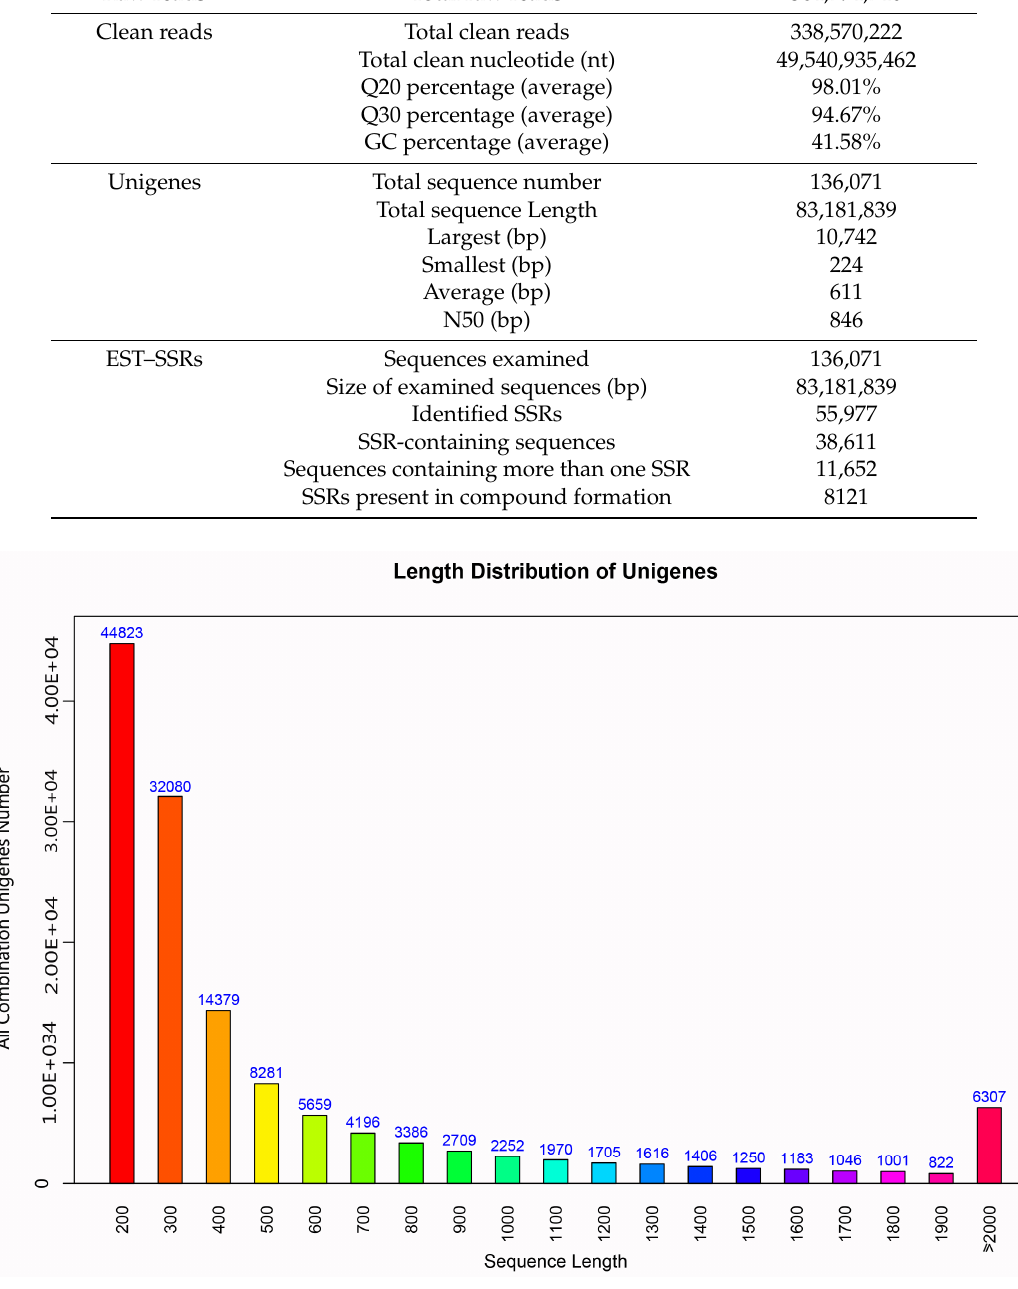
Table 1. Summary of transcriptome sequencing and assembly in Styrax japonicus.